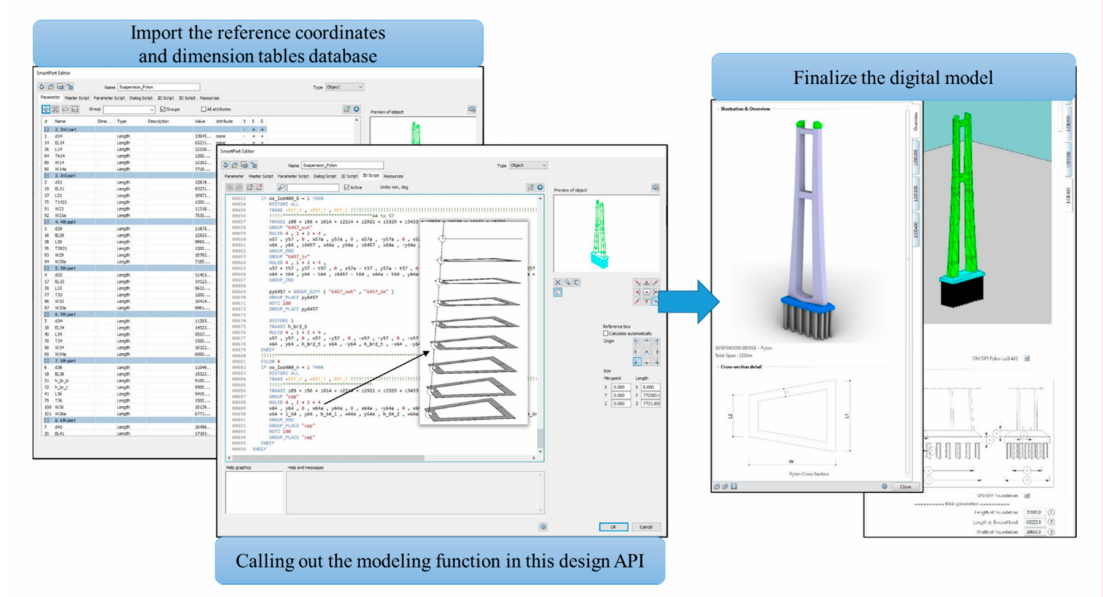
Figure 11. Example for creation of a typical pylon digital model in an open-source design